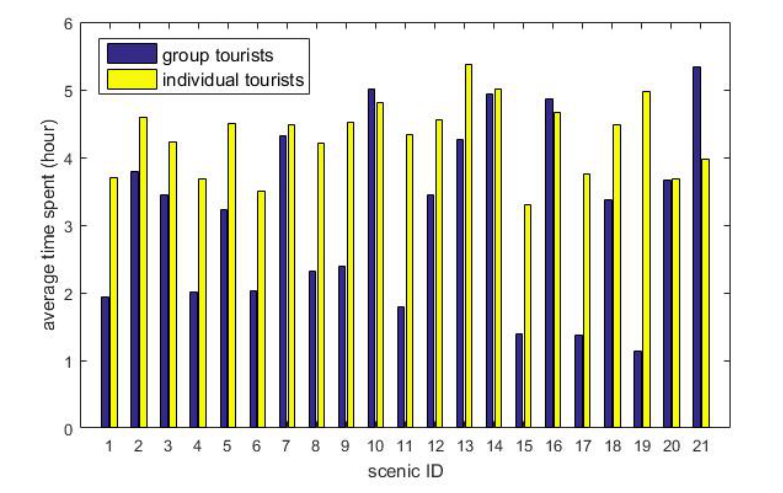
Figure 6. Average time spent in different scenic areas. Table 5. Scenic area identifications and corresponding